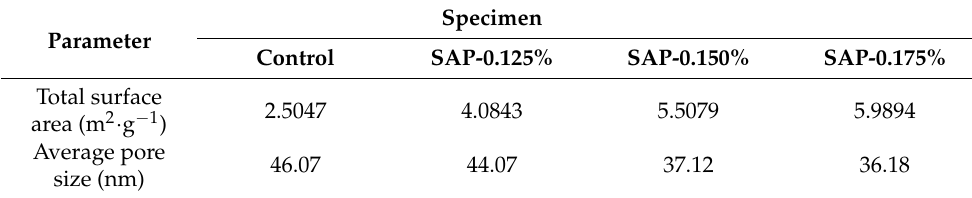
Figure 9. Curve of pore size distribution of pavement concrete before salt freeze–thaw test. Table 7. Total surface area and average pore diameter before salt freeze–thaw test.